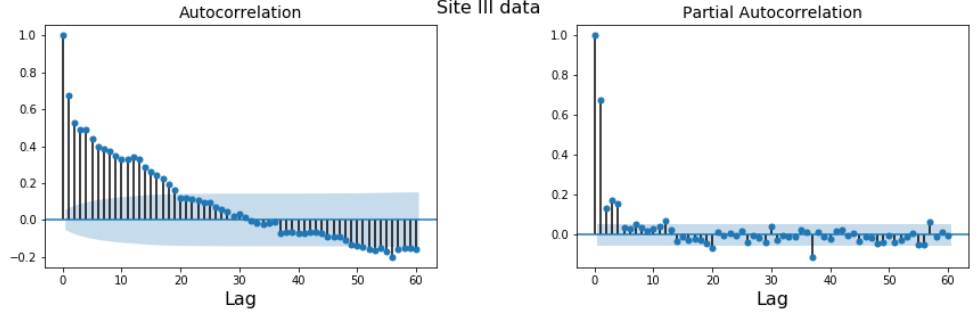
Figure 7. Autocorrelation ( left ) and partial autocorrelation ( right ) for Site